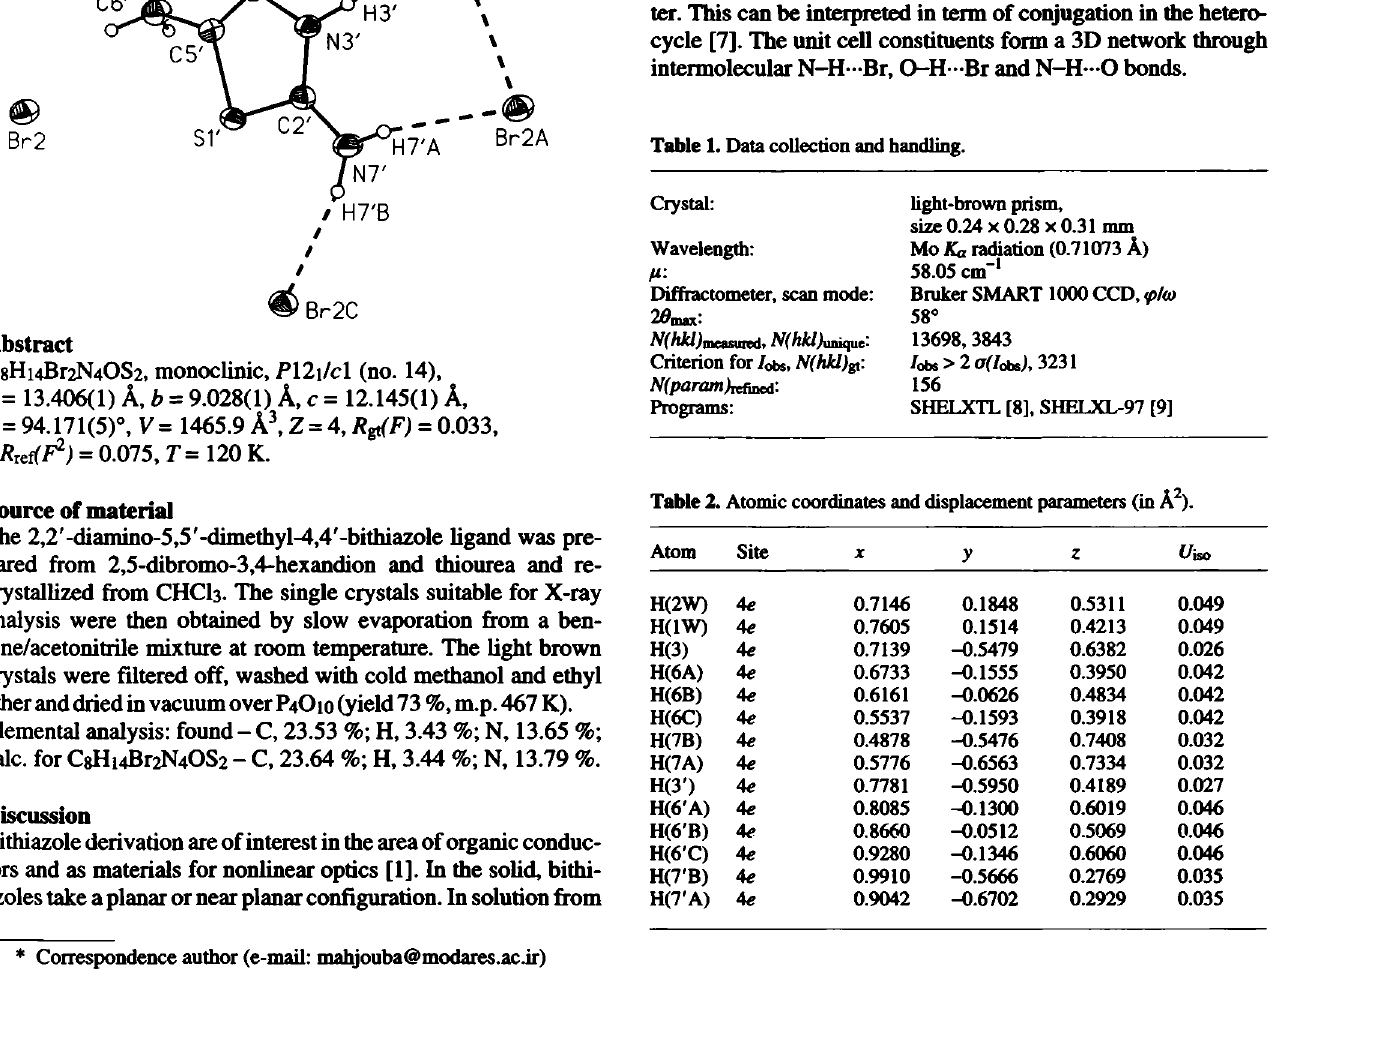
Table 1. Data collection and handling.